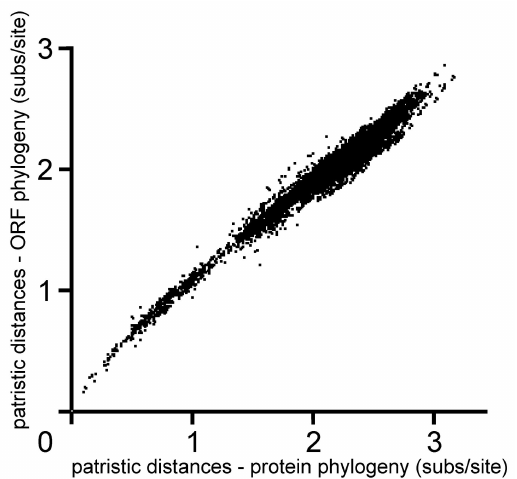
Figure 4. A graph comparing the patristic distances of the ML tree of ORFs in Figure 3a,b and the ML tree of the protein sequences encoded by these ORFs; 149 potyviruses and three rymoviruses are